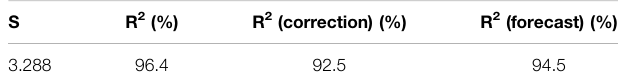
FIGURE 5 | Interaction between angular property and axial coef fi cient. TABLE 7 | Summary of standard deviation of fi tting equation.